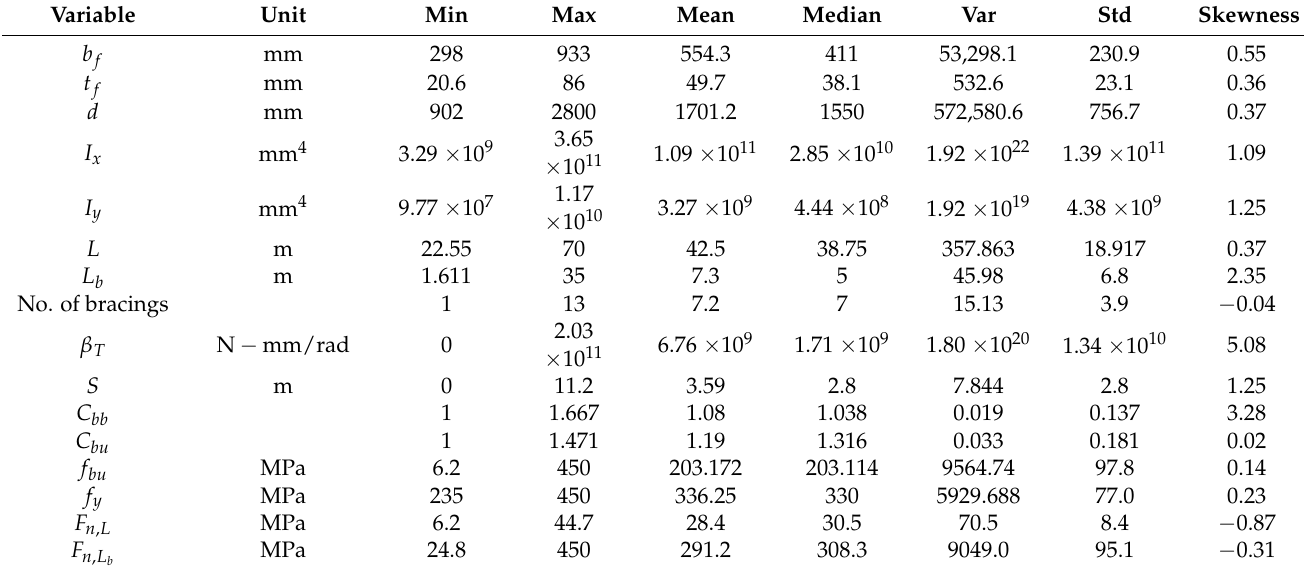
Table 5. Ranges of design parameters for input parameters used in this study.